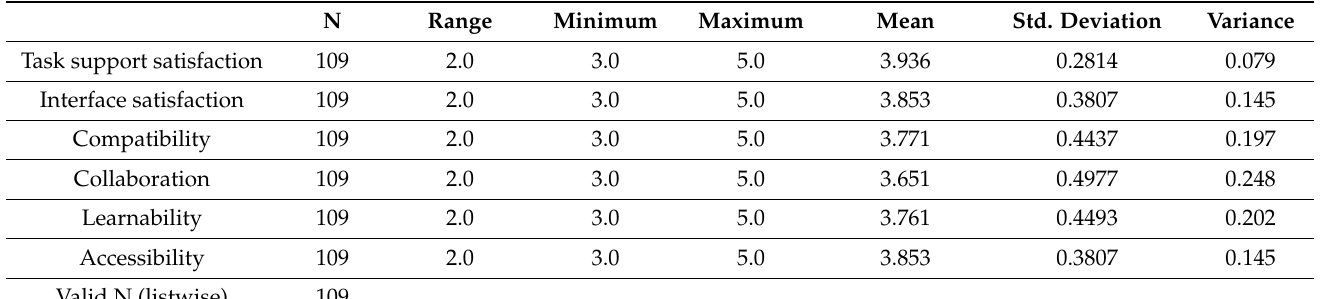
Table 5. HIS component descriptive statistics.